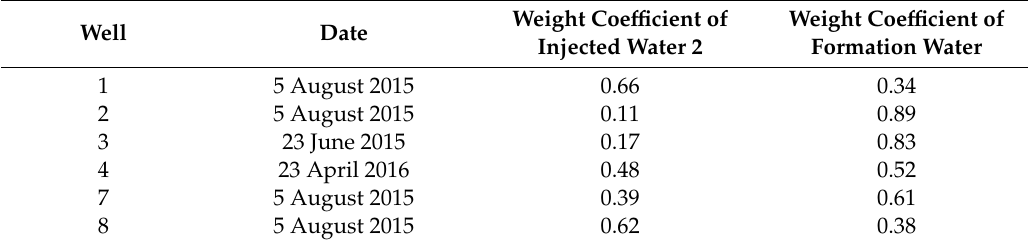
Table 8. Weight coe ffi cient of formation and injected water in the produced water after 28 May 2015. Well Date